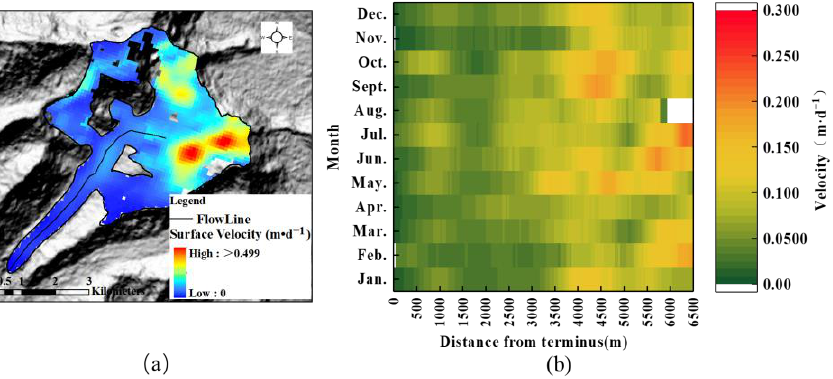
Figure 8. Changes in the monthly average velocity of the Kuokuosele Glacier along the centerline in 2015–2016. ( a ) Monthly average velocity along the centerline in 2015–2016. ( b ) Monthly average velocity during 2015–2016.